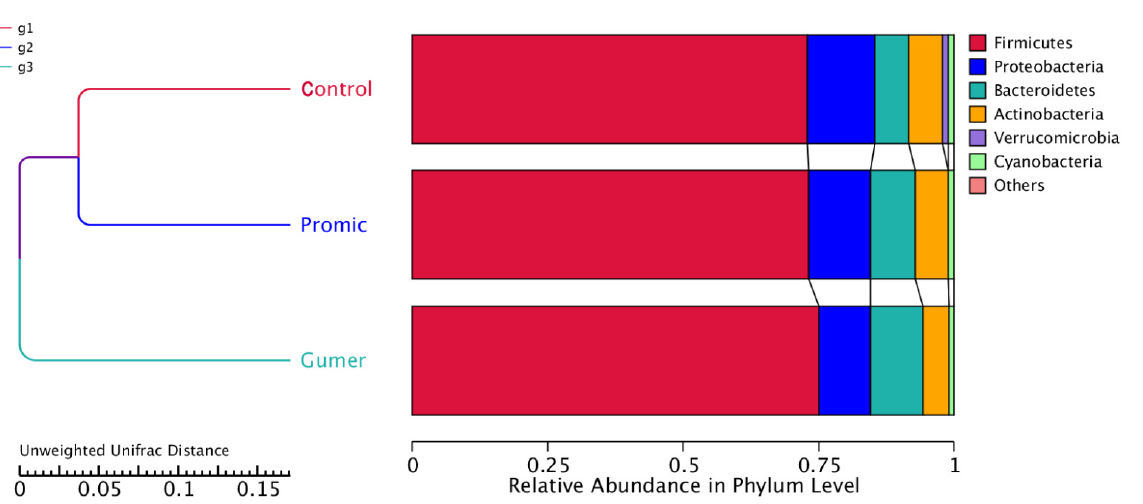
Figure 4. UPGMA cluster tree of the phylum level based on unweighted UniFrac distance. 3.2.6. Principal Coordinates Analysis Principal coordinates analysis (PCoA) is an ordination technique that extracts the fundamental elements and structures from reduced multidimensional data series of ei ‐ genvalues and eigenvectors. In comparison to principal component analysis (PCA), this technique has the advantage of allowing for the investigation of each ecological distance. The weighted and unweighted UniFrac coefficients are calculated to aid in the PCoA anal ‐ ysis, and the result is shown in Figure 5. Three samples were distributed in three different locations, demonstrating the significant variation between the three samples. This